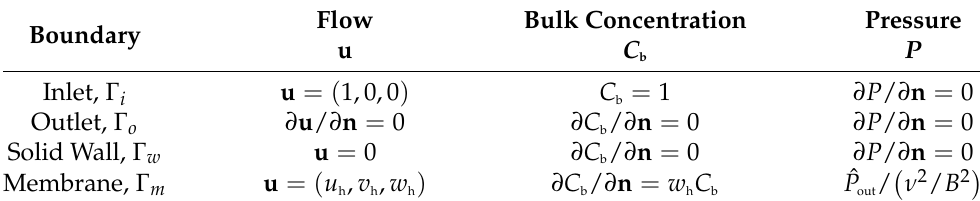
Table 1. Boundary Conditions for the